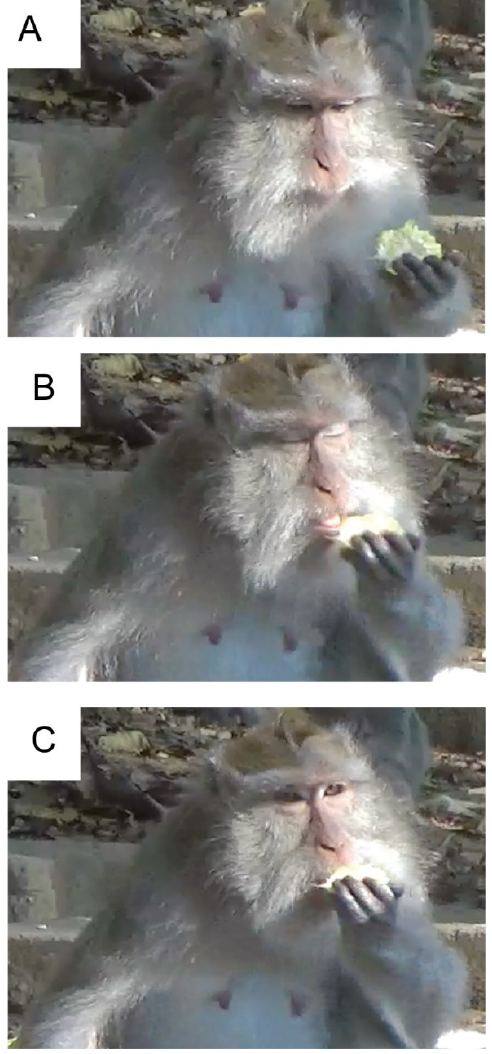
Blink with Disengage by a Macaque Named